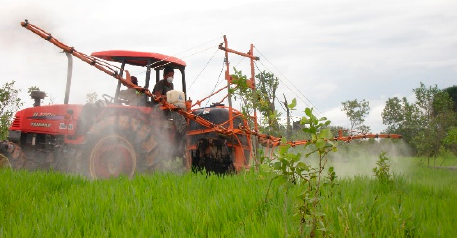
Figure 9. Application of herbicide in the Brachiaria decumbens dominated grass.